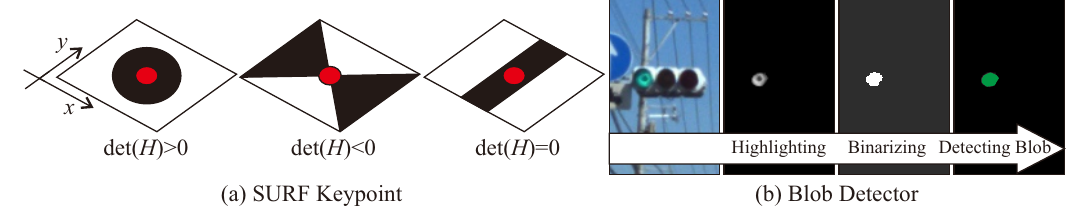
Figure 7. Candidate